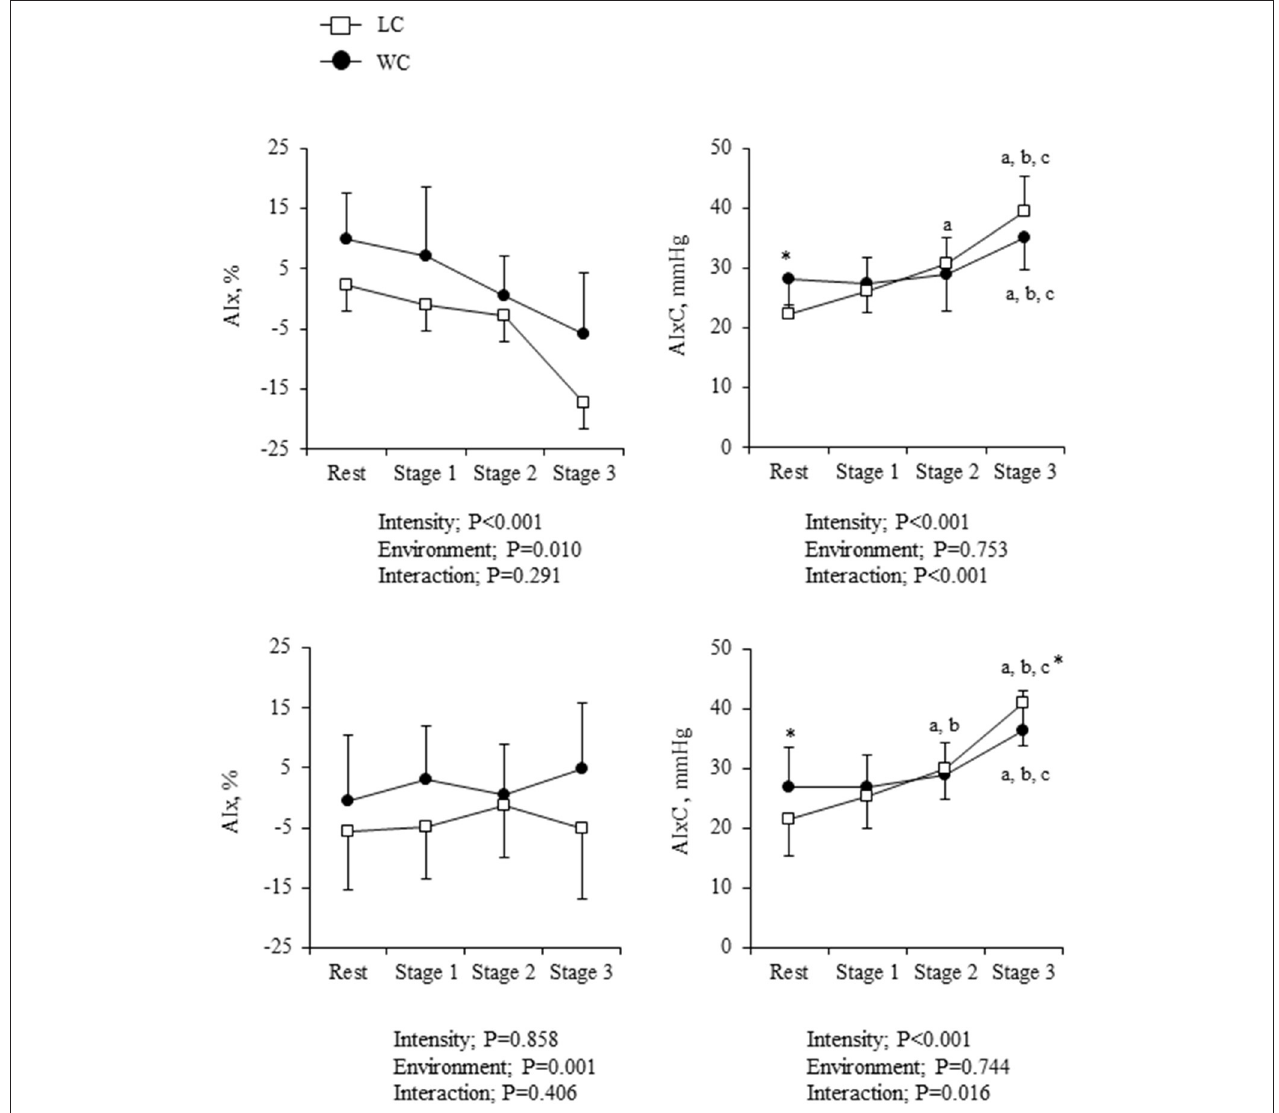
FIGURE 5 | Augmentation index (AIx) and the companion metrics of AIx (AIxC) at rest and during exercise: absolute values ( top ) and heart rate (HR)-corrected values via analysis of covariance (ANCOVA) ( bottom ). Symbols and error bars are mean and SD. The circle and square indicate water-based and land-based exercise, respectively. a,b,c show significant differences from rest, stage 1, and stage 2 of the same environment, respectively. *indicates a significant difference from land at the same